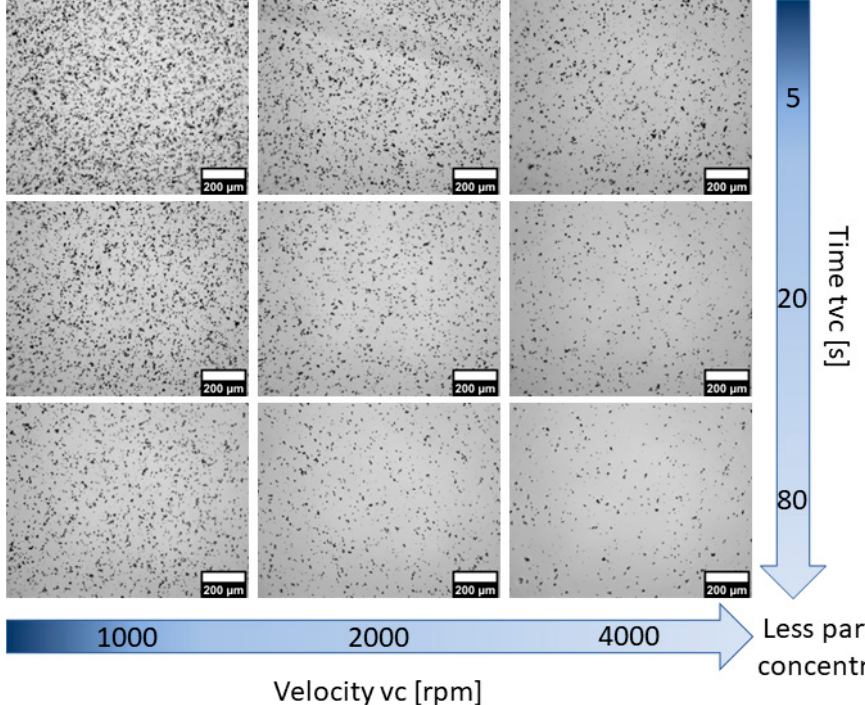
Figure 7. Optical microscopy images of the PDMS-GOS:Eu membranes (2.5% wt./wt. concentration) fabricated at different spin-coating velocities ( v c ) for different spinning times ( t vc ).